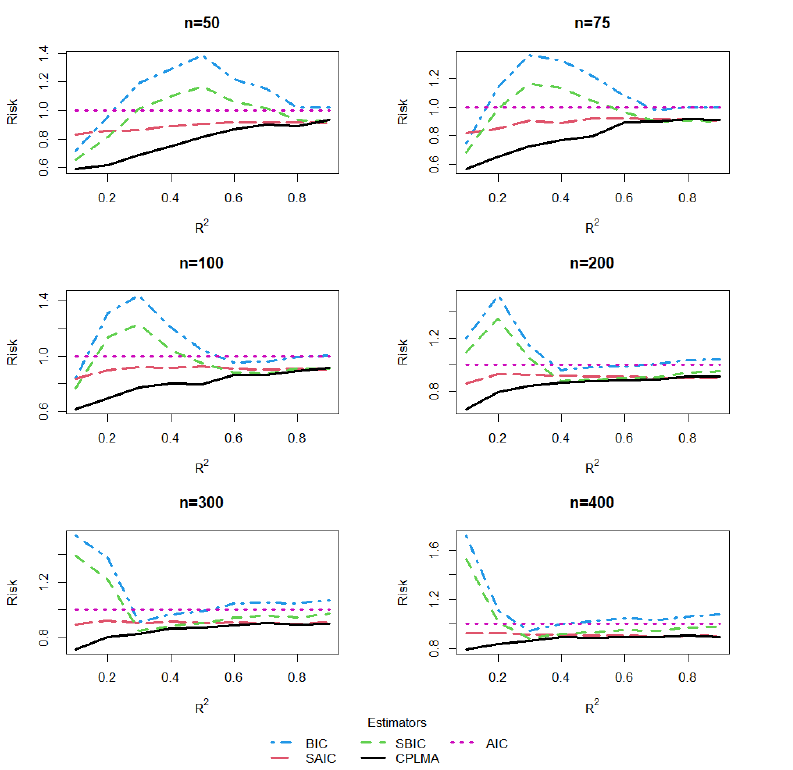
Figure 6. Risk comparisons for Design 2 when α = 2 and the censoring rate is about